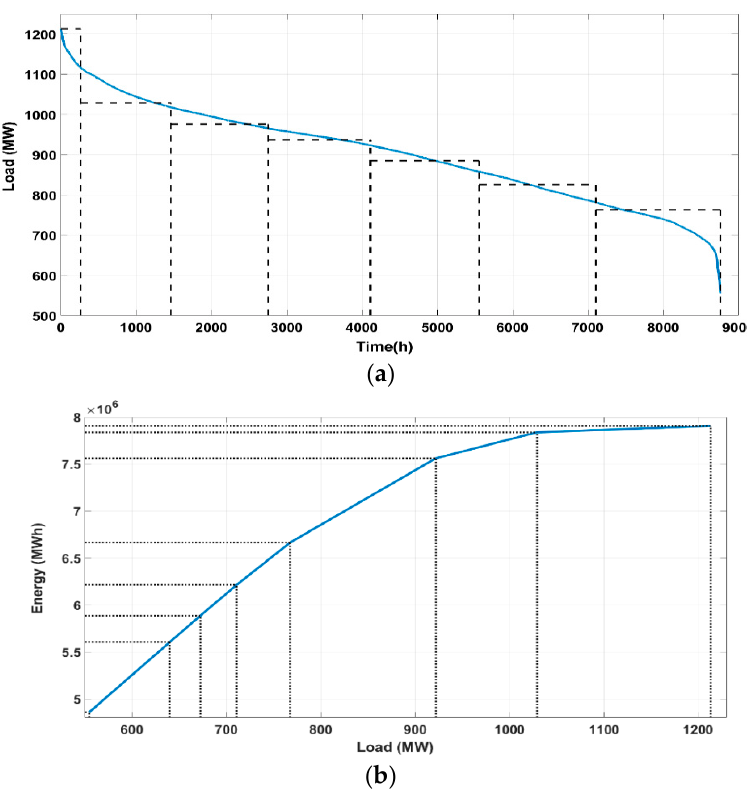
Figure 6. Load curves used in analysis: ( a ) LDC and stepwise representation of LDC; ( b ) Piecewise linear load-energy curve.